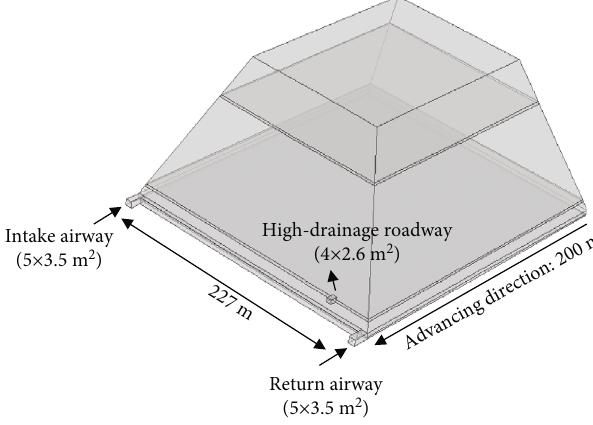
Figure 3: Numerical calculation model of 7607 working